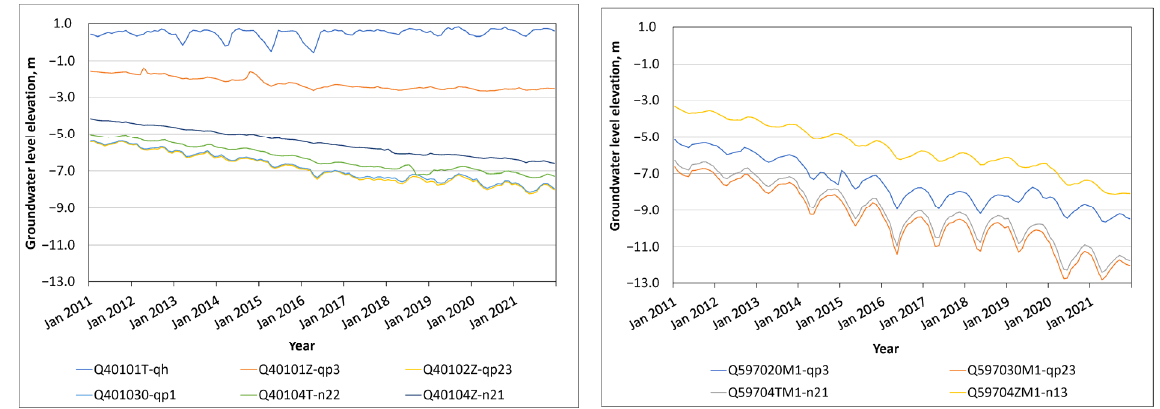
Figure 7. Observation data from different aquifers at Q401 and Q597 (source: NAWAPI [18]).